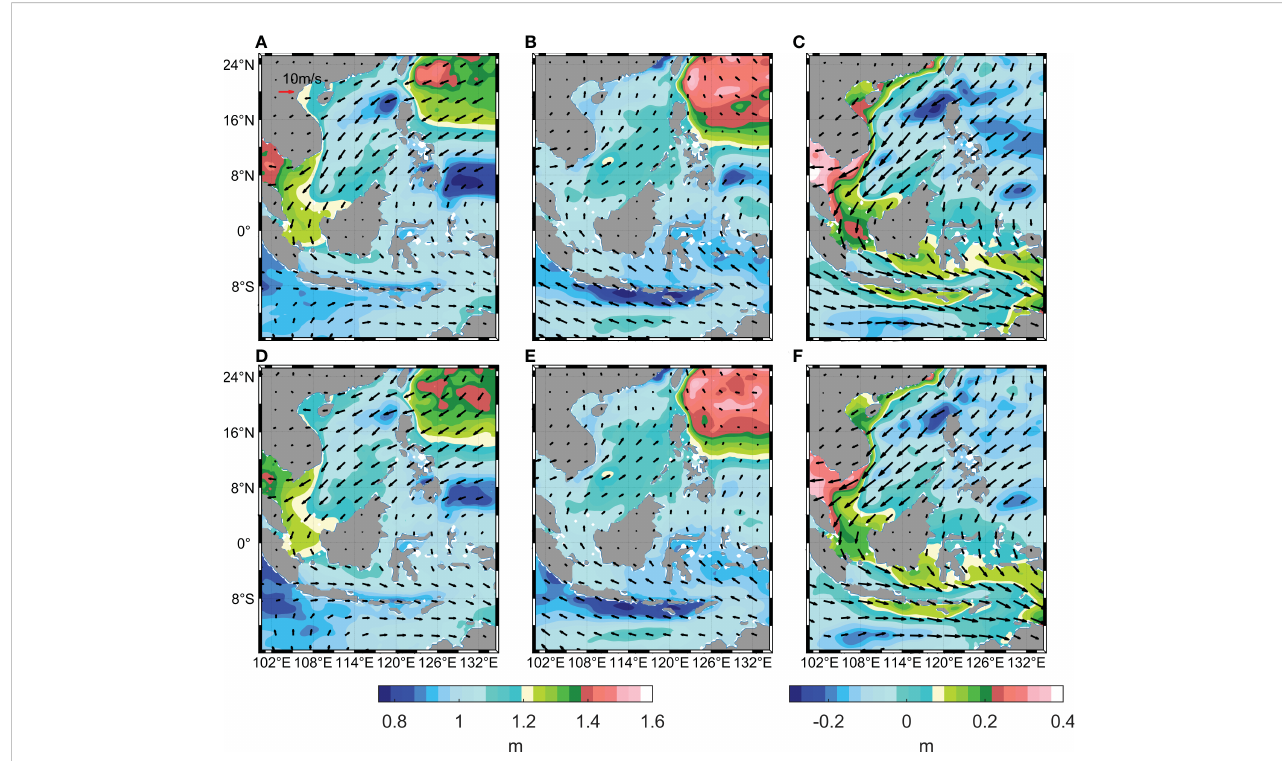
FIGURE 12 Composite analysis results of SSH and SSW fi eld in winter (A) and summer (B) and the seasonal amplitude (C) in warm PDO phases. Composite analysis results of SSH and SSW fi eld in winter (D) and summer (E) and the seasonal amplitude (F) in cold PDO